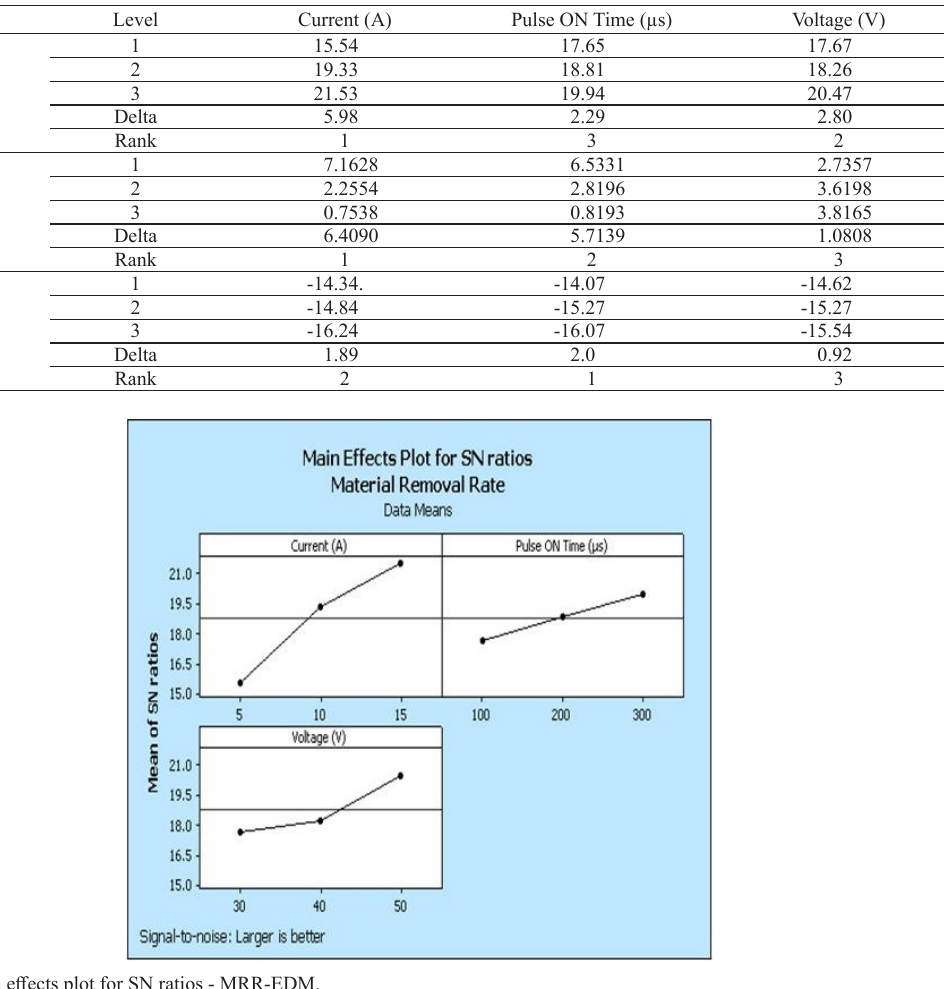
Table 2. Mean of SN ratios for the MRR, TWR and SR